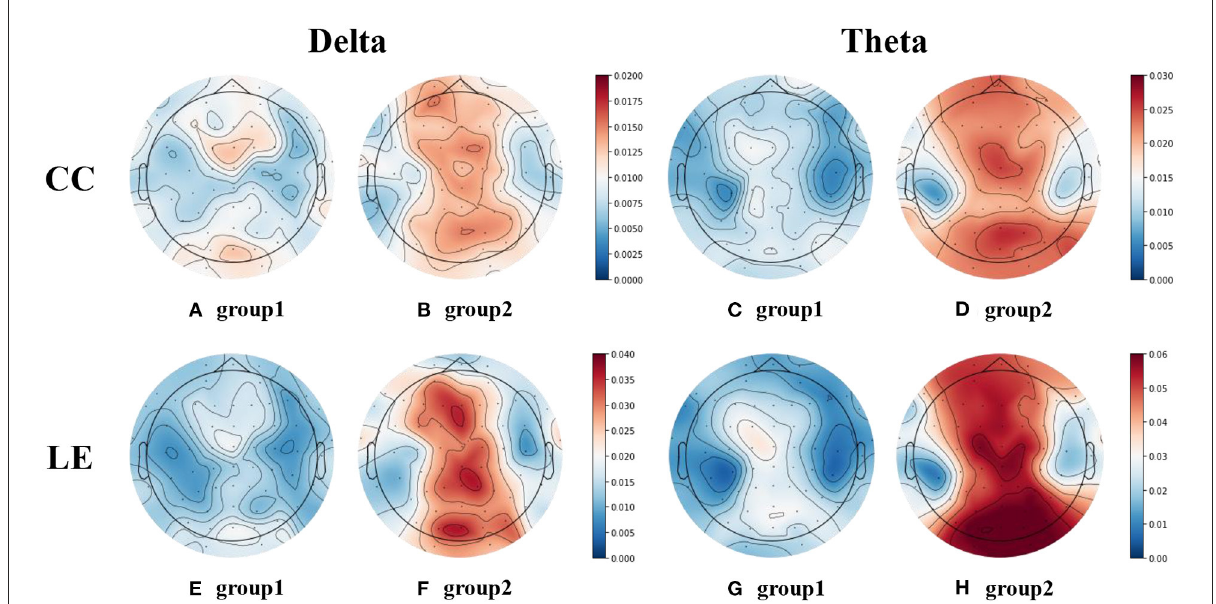
FIGURE9 EEG topographic maps of CC and LE in delta and theta bands. (A,B) are the EEG topographic maps of CC in delta band for the two groups. (C,D) are the EEG topographic maps of CC in theta band for the two groups. (E,F) are the EEG topographic maps of LE in delta band for the two groups. (G,H) are the EEG topographic maps of LE in theta band for the two groups.